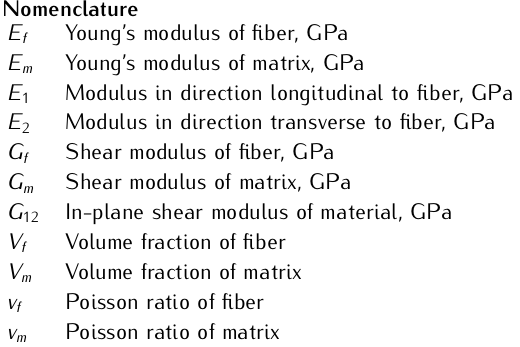
patterns (Fig. 3) are investigated using Finite Element Methods (FEM) before the first prototype is built.